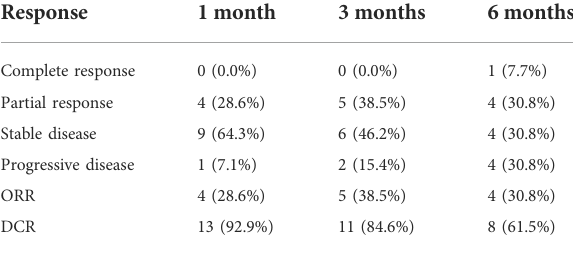
TABLE 3 Local tumor response.